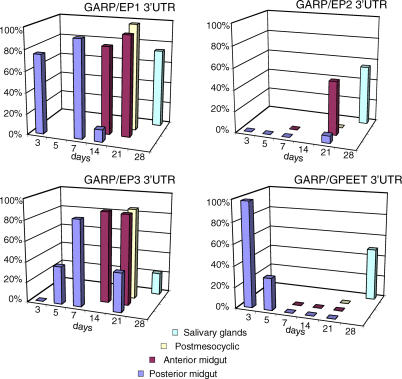
Effect of Procyclin 3′ UTRs on Expression of a Reporter Gene during Fly TransmissionThe coding region of GARP was fused to individual procyclin 3′ UTRs and stably integrated in place of the corresponding procyclin coding region. The percentage of trypanosomes expressing GARP in different compartments of the digestive tract and the salivary glands of the tsetse fly was determined by immunofluorescence analysis. For the sake of clarity the figures are set to the same scale. Blank spaces on the graphs indicate that no samples were taken from a particular tissue.